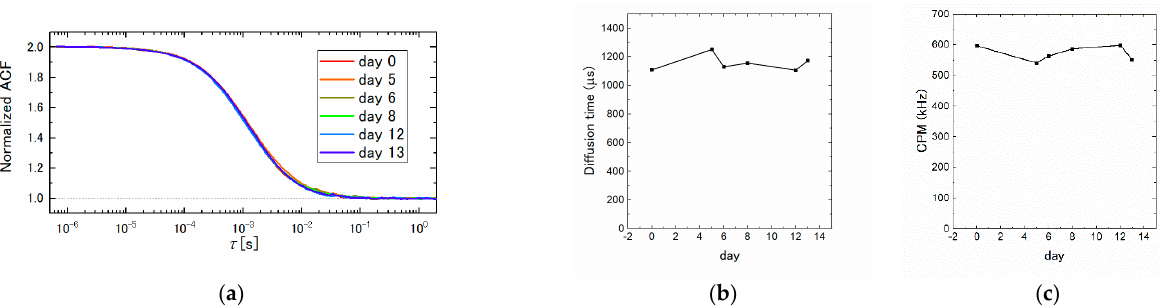
Figure 4. FB-FCS measurements on fluorescent beads on different days. ( a ) Normalized ACFs. ( b ) Diffusion time. ( c ) CPM.